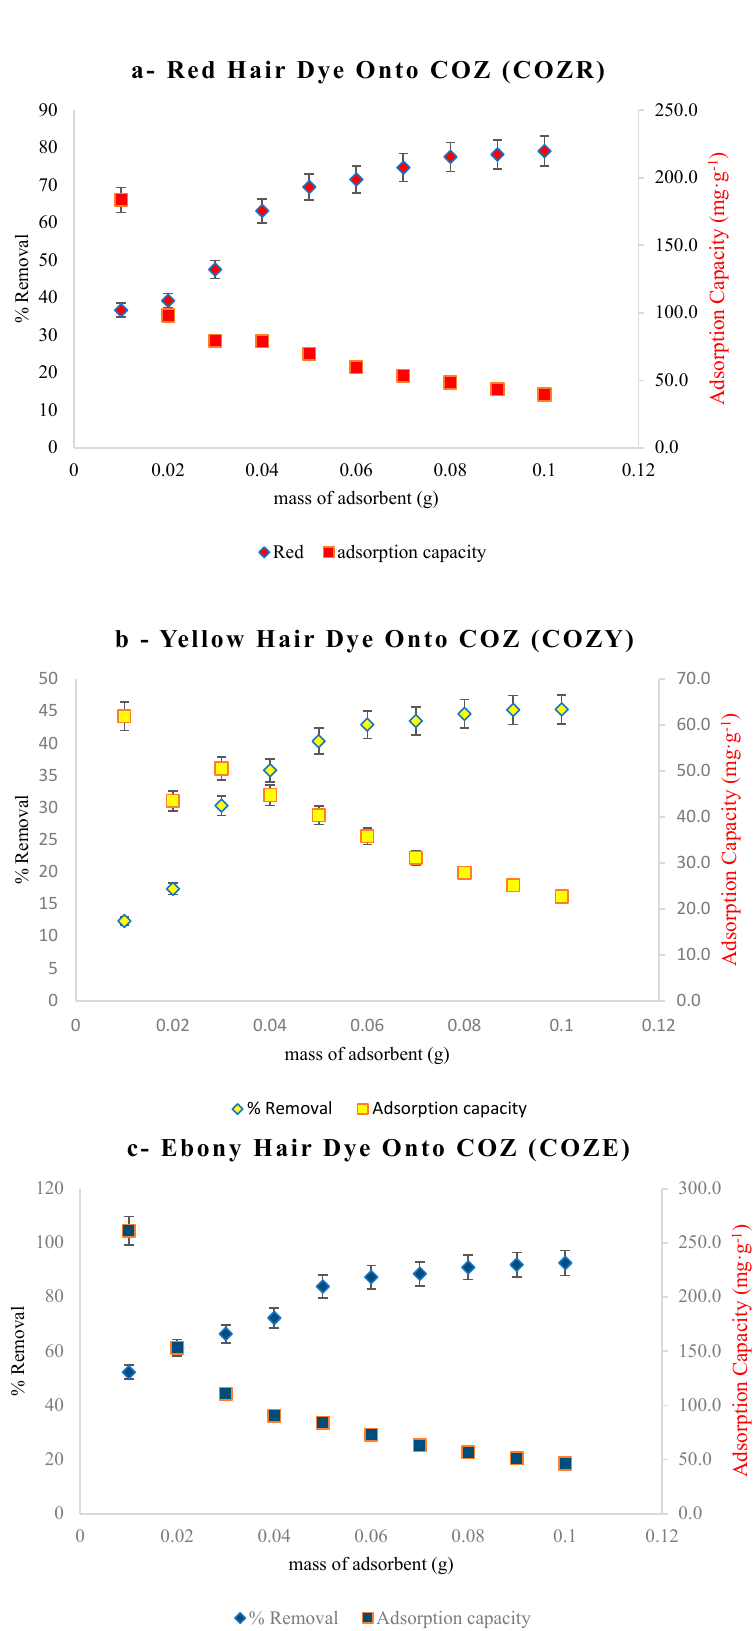
Figure 4. Effect of adsorbent dosage on the adsorption of ( a ) red hair dye onto COZ ( b ) yellow hair dye onto COZ, and ( c ) ebony hair dye onto COZ [adsorbent dosage = 0.01–0.1 g, C i = 50 mg · L − 1 ; pH = 7.0, and contact time = 60 min, and T = 25 ± 1 °C, speed = 150 rpm] .